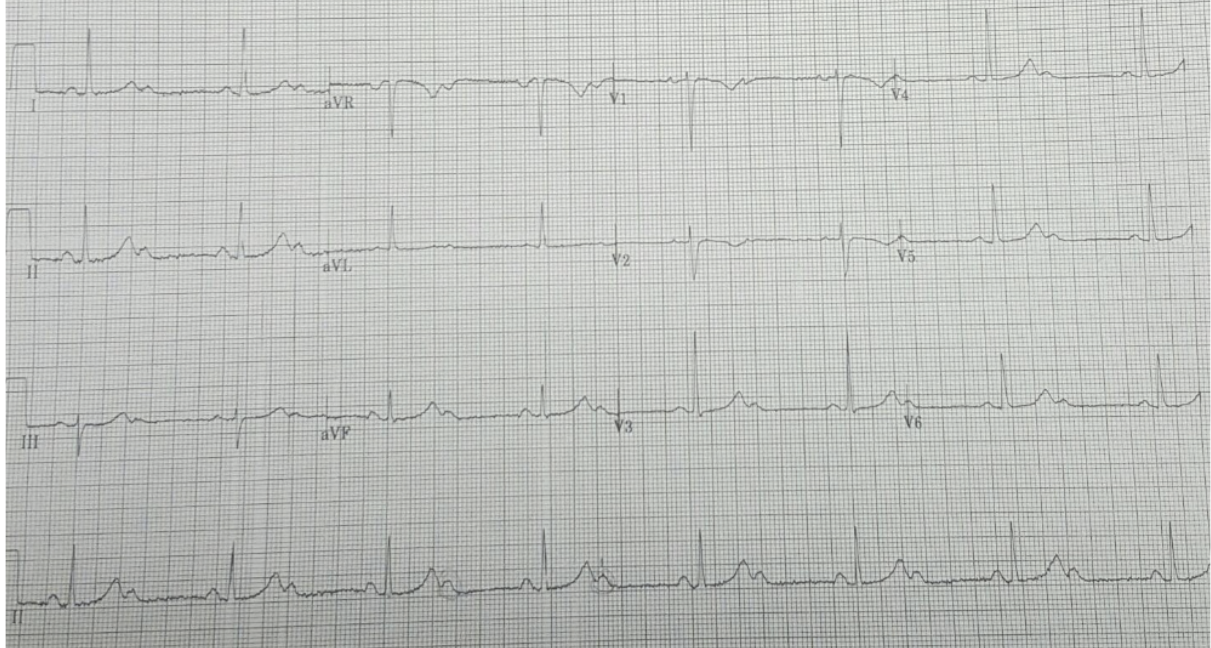
Figure 1: Initial EKG at the emergency department, showing 2nd-degree Mobitz type 2 atrioventricular (AV) block 2: 1, heart rate 40 bpm, normal QRS voltage and complexes, T waves, and ST